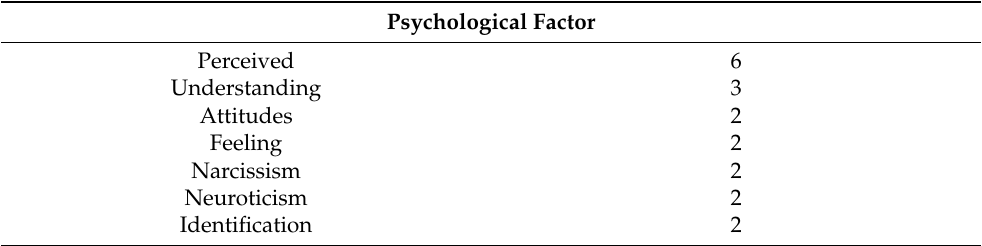
Table 3. Frequency and category of subject terms in the study of psychological factors in the relationship between leadership and